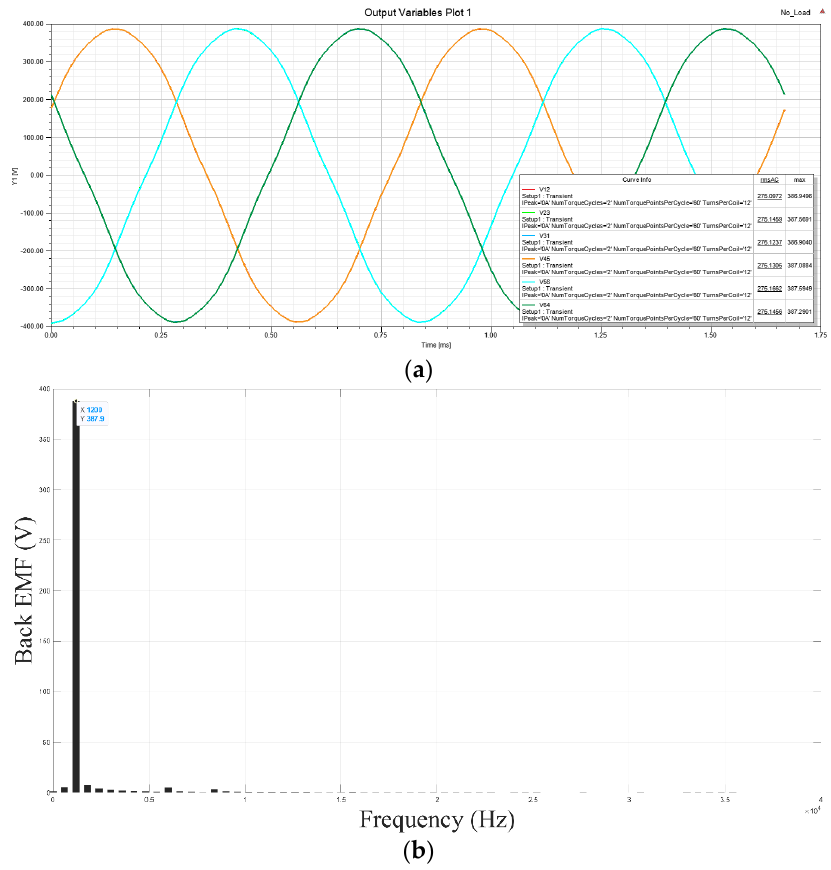
Figure 7. The waveform of ( a ) no-load line-line back EMF, ( b ) analysis of harmonics. Table 6. Performance indicator.